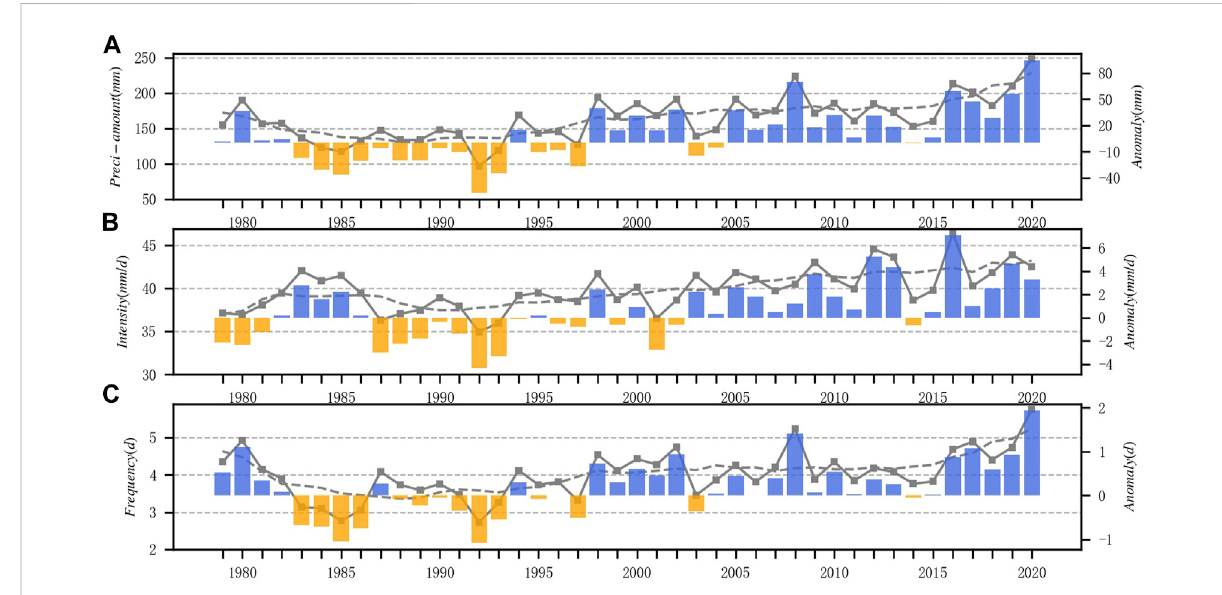
FIGURE 2 Eastern China: time series of extreme precipitation amount (A) ; time series of extreme precipitation intensity (B) ; time series of extreme precipitation frequency (C) . The dotted line in each panel represents the 9-years moving average, and the bars represent the